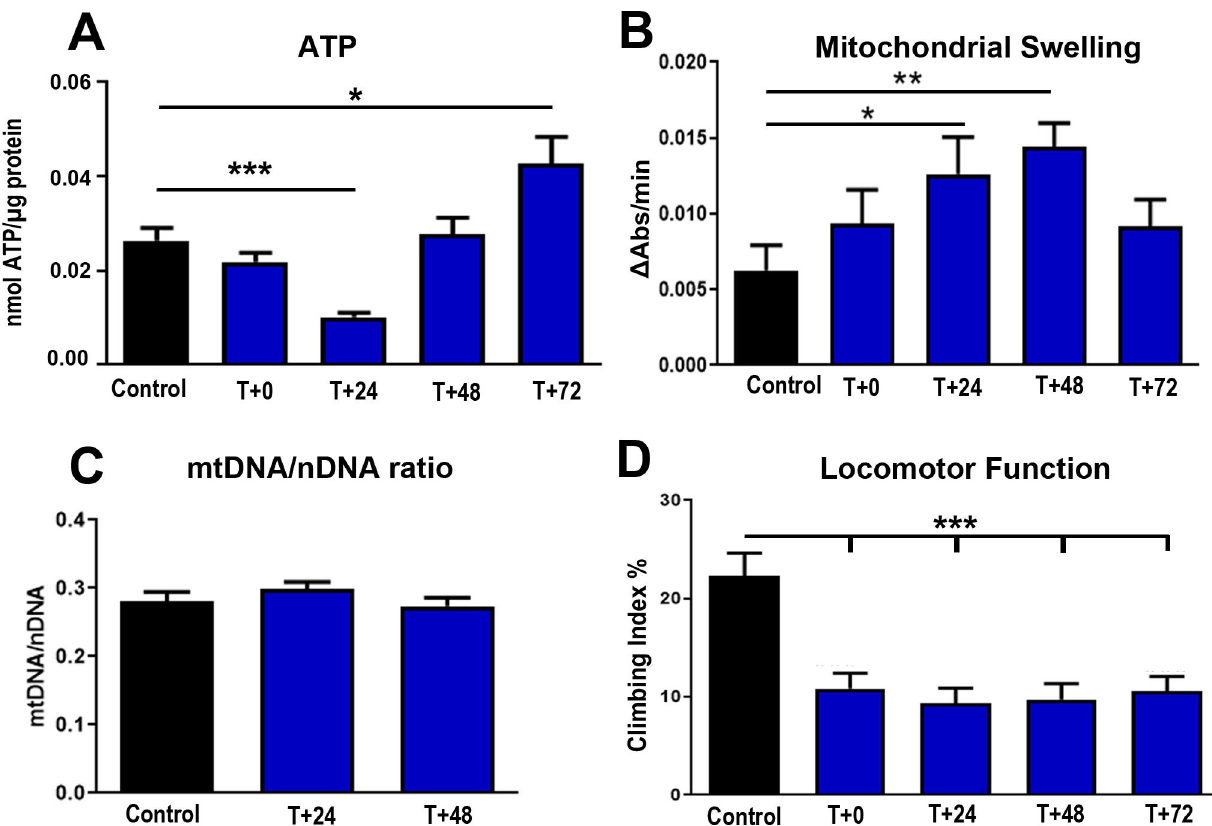
Fig 4. Three hours 420nm light reduced ATP significantly at 24h but there was a strong bounce back from this, significantly increasing levels found at 72h over controls that were not exposed to 420nm light (A). Similar patterns are found with mitochondrial hypotonic swelling, which increased progressively over 48h, but then declined to within the normal range (B). The longer exposure did not change mitochondrial DNA content (C). There is a significant reduction in climbing ability of > 50%, which did not recover when animals were re-tested at 24, 48 and 72h post exposure (D). Abbreviations: � p < 0.05, �� p < 0.01, ��� p <